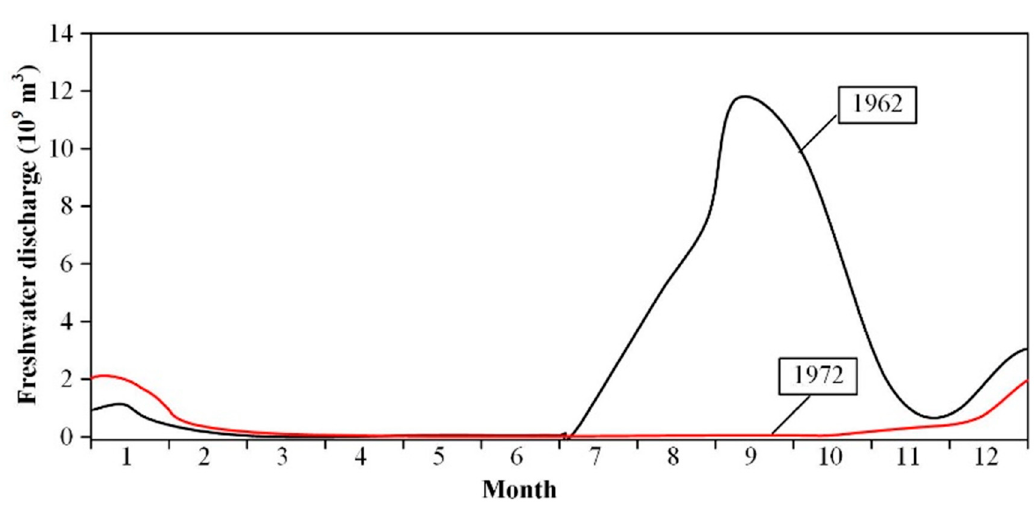
Figure 4. Freshwater discharge before and after construction of the Aswan High Dam [41].